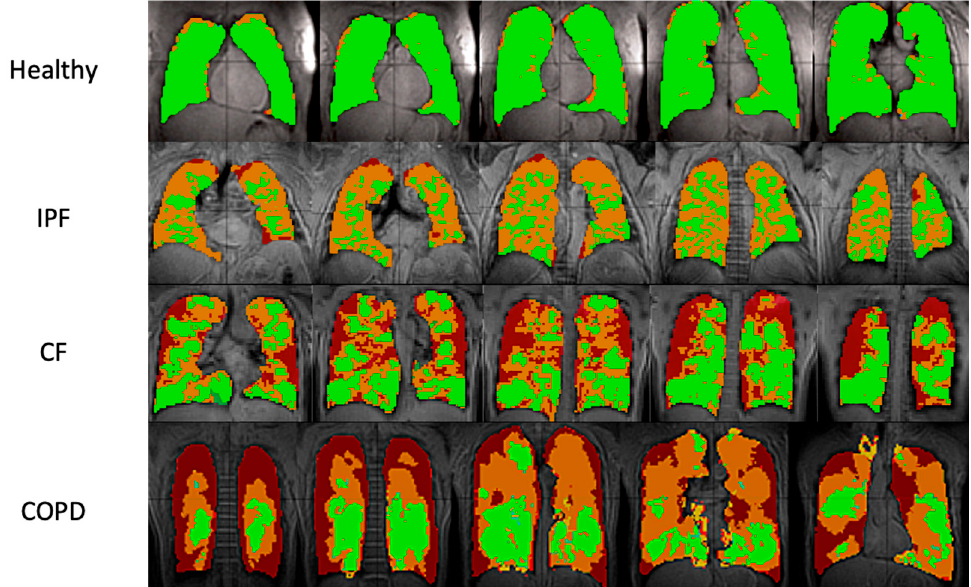
Figure 2. Ventilation images overlaid on proton images in sample healthy, IPF, CF, and COPD subjects. Each row shows five lung slices from anterior ( left ) to posterior ( right ). Green areas indicate regions of normal ventilation and hyperventilation. Orange areas indicate regions of hypoventilation. Red areas indicate regions of no ventilation. Table 1. Averages and standard deviations for subjects and computed parameters for each disease type.